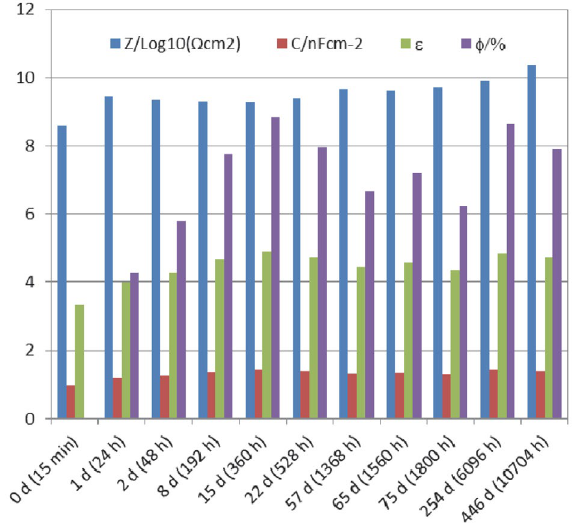
Figure 9. PA7 coating parameters calculated from EIS measure- ments for different times of exposure to 3.5% NaCl.